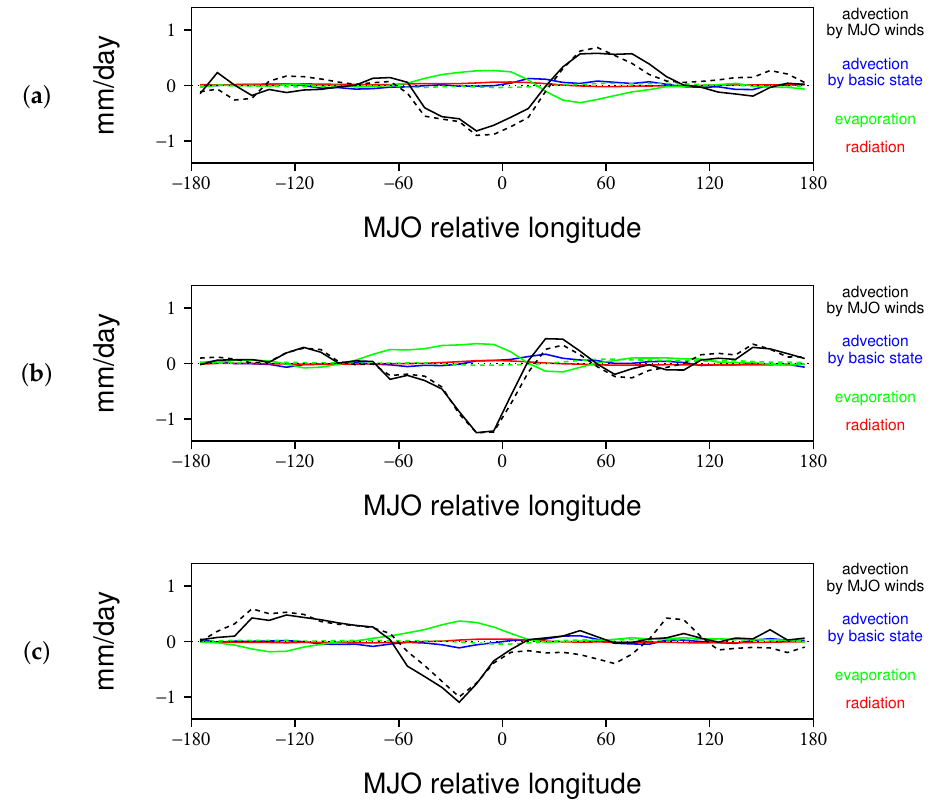
Figure 5. Key terms in the moist enthalpy budget of the composite LAM MJO for the developing, mature, and dissipating stages, respectively ( a – c ). Advection of moisture and heat by MJO wind perturbations (black line), the contribution of the deep convective mode to moisture and heat advection (black dashed line), advection of perturbation heat and moisture by basic state winds (blue line), evaporation (green line), and radiation (red